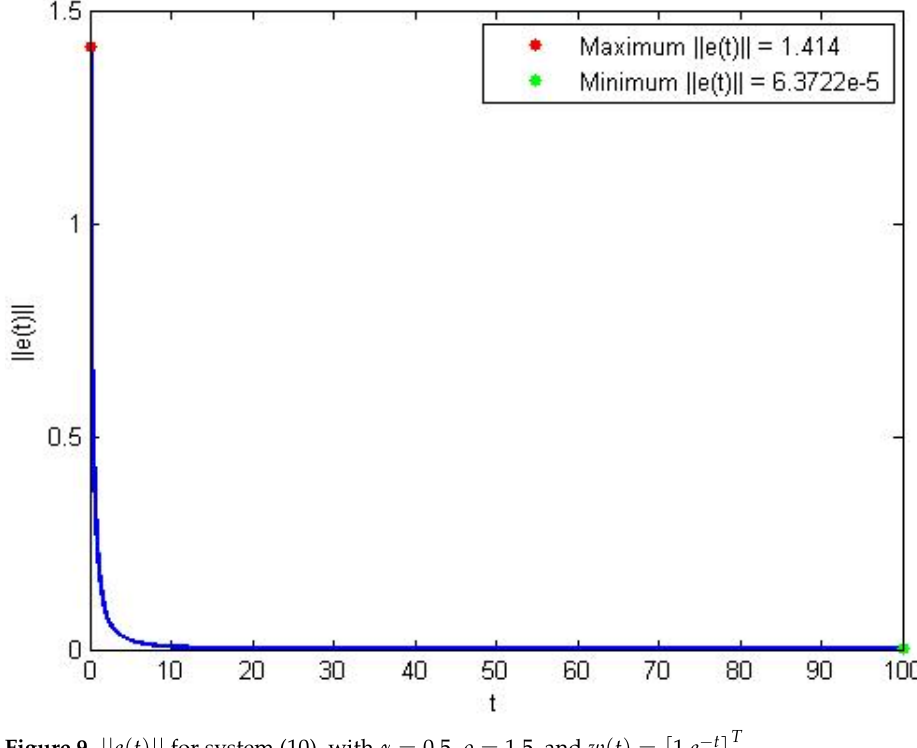
Figure 9. || e ( t ) || for system (10), with α = 0.5, ρ = 1.5, and w ( t ) = Figure 9. ‖𝑒(𝑡)‖ for system (10), with 𝛼 = 0.5 , 𝜌 = 1.5, and 𝑤(𝑡) = [1 𝑒 −𝑡 ] 𝑇 .